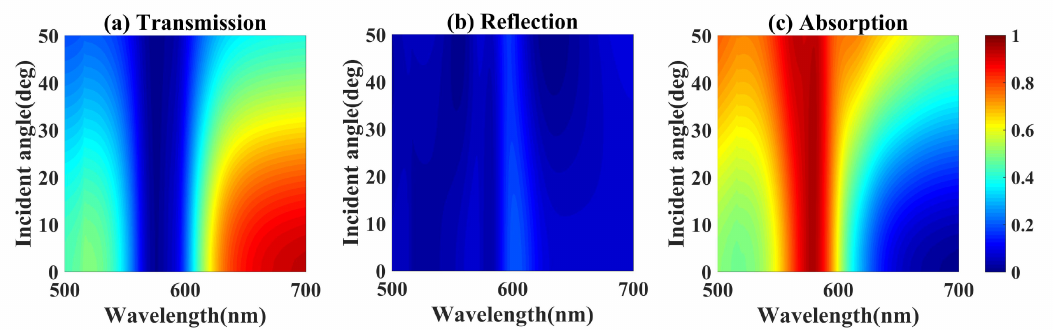
Figure 5. The simulated ( a ) reflection, ( b ) transmission and ( c ) absorption spectra of the a-Si nanostructure metasurface as a function of incident